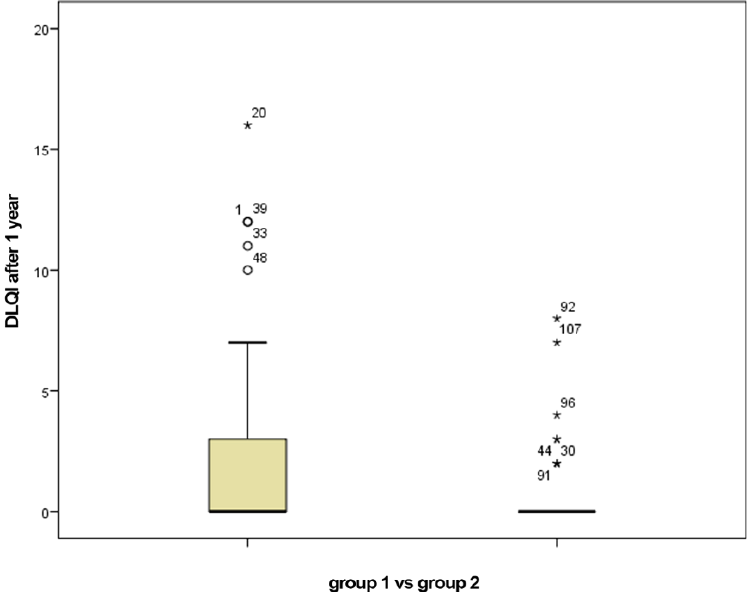
Figure 2. DLQI after 1 year of biological therapy for group 1 (smokers) vs. group 2 (non-smokers). Table 2. DIFFDLQI in group statistics. Smokers